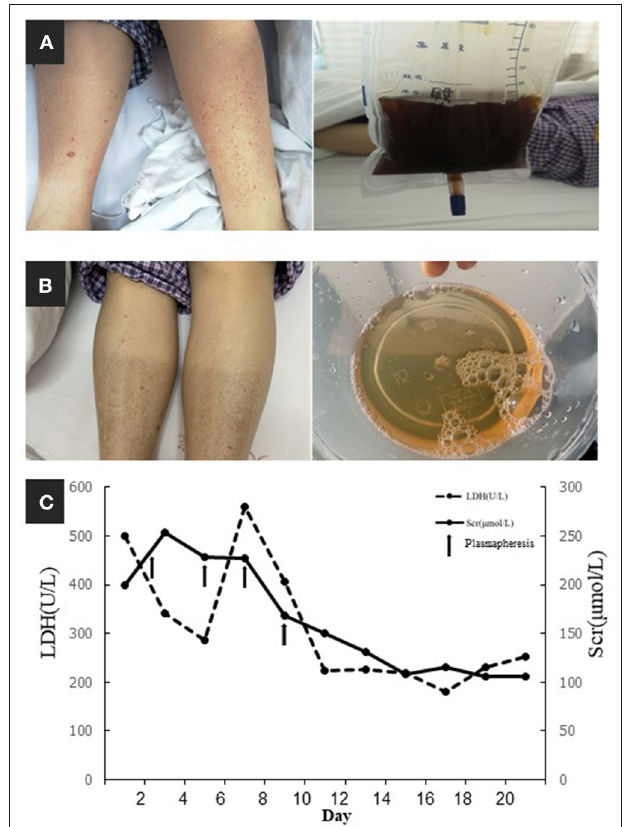
FIGURE 1 | (A) Skin purpura and typical soy-colored urine. (B) The remission of purpura and hematuria. (C) Timeline of serum creatinine (Scr) and lactate dehydrogenase (LDH) and their relationships with plasmapheresis (arrows indicated plasmapheresis).